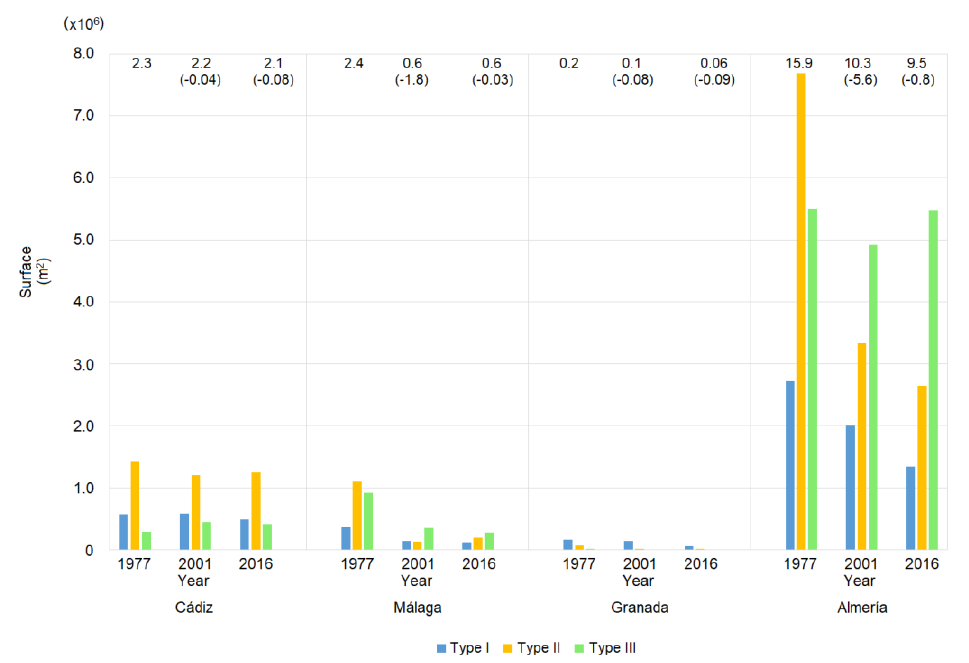
Figure 4. Distribution of dune surface typologies, i.e., “Embryo and mobile dunes” (Type I), “Grass-fixed dunes” (Type II) and “Stabilized dunes” (Type III), by province during the studied periods. The value on top represents the sum of dune surfaces (in m 2 ) and in brackets the value of lost dune surface with respect to the previous year is presented.